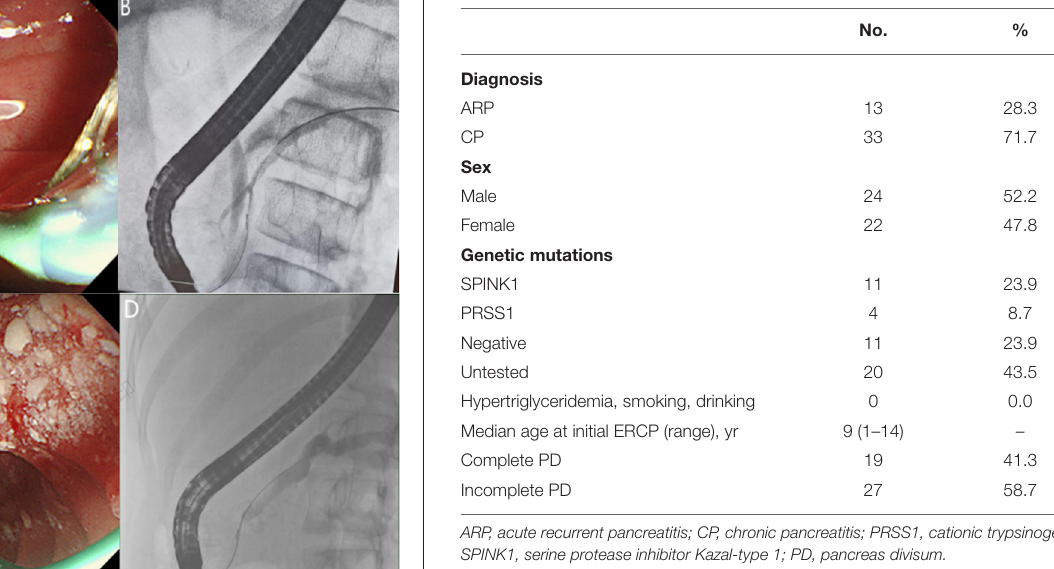
TABLE 1 | Baseline characteristics of 46 pediatric patients with pancreas